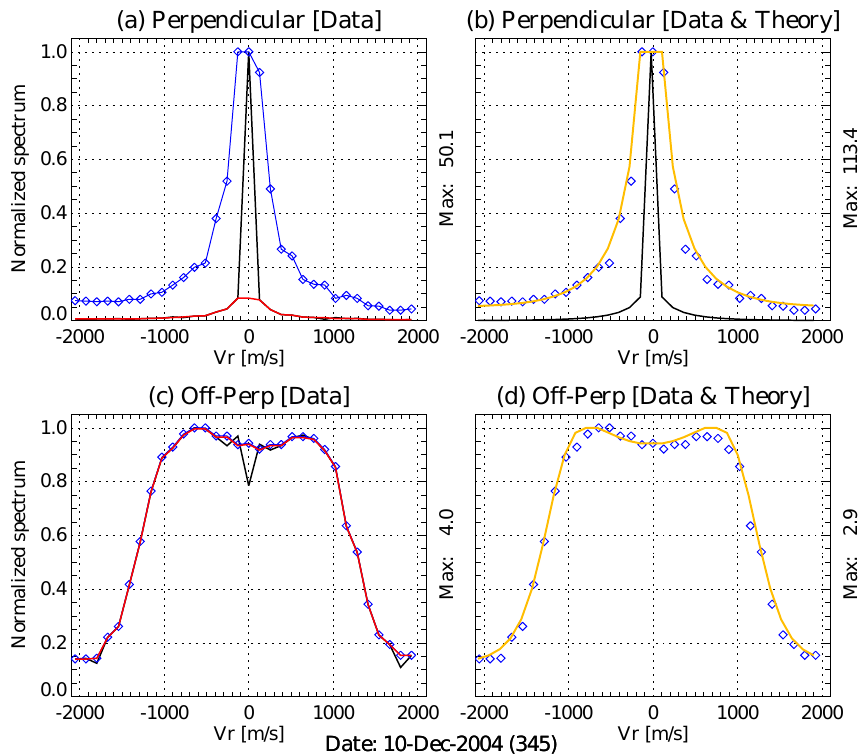
Fig. 6. Normalized 150-km spectra from (a) Perpendicular, and (c) Off-perpendicular data around 168km after 3-min averaging. The time corresponds to the spectra shown in Fig. 3. A normalized spectrum after 3-point median filter is shown in red, while the normalized to its peak filtered series is shown in blue diamonds. In the second column we compare the normalized smooth spectra with a theoretical ISR spectrum in orange (see text for